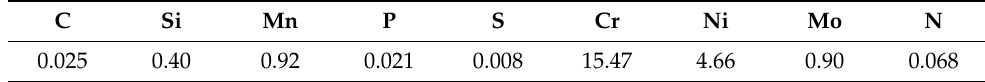
Table 2. Chemical composition of the steel 1.4418. Values are in wt. %.